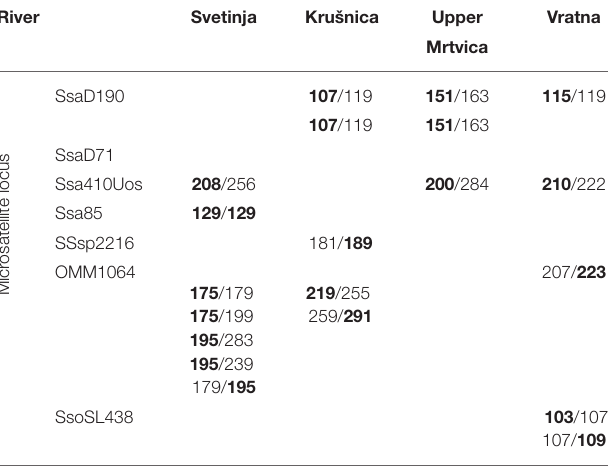
TABLE 3 | Pairwise F ST distance values (above and right of the diagonal) and their significance ( p- values) levels between samples from (A) Una River catchment and (B) Iron Gate Gorge area (the pairwise F ST distance value between the upper and lower Mrtvica River populations is 0.22060, p < 0.05).